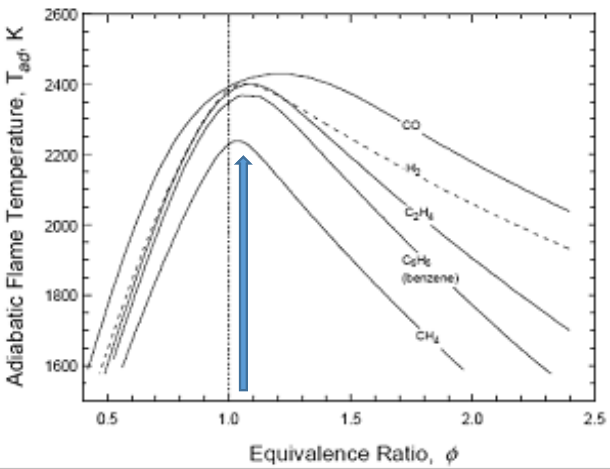
Figure 8. Adiabatic flame temperature and air-to-gas equivalence ratio [17].